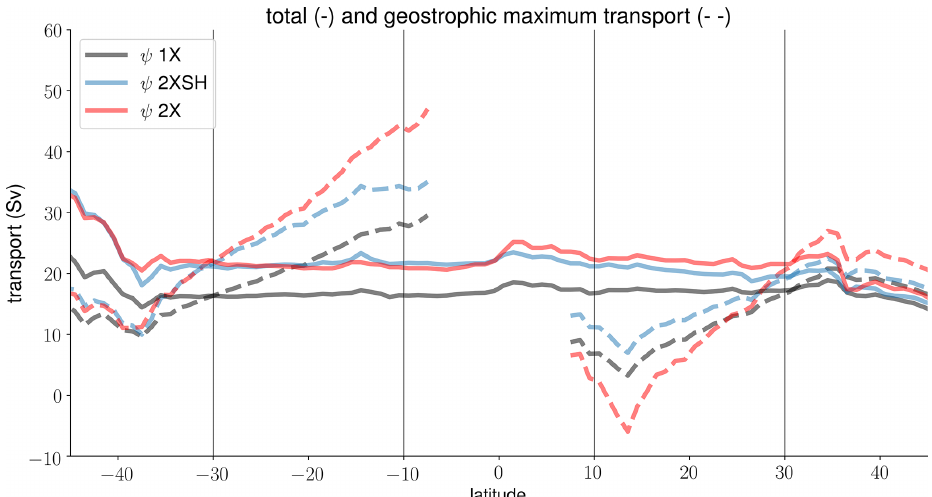
Figure 5. The time-mean (1991–2010) wind forcing dependencies of the total maximum overturning streamfunction ψ t (solid) and the geostrophic maximum overturning streamfunction ψ g (dashed) in the 1X experiment (black), the 2XSH experiment (blue), and the 2X experiment (red). Considering ψ g , we exclude the equatorial band where the approximation of the surface Ekman flux breaks down.